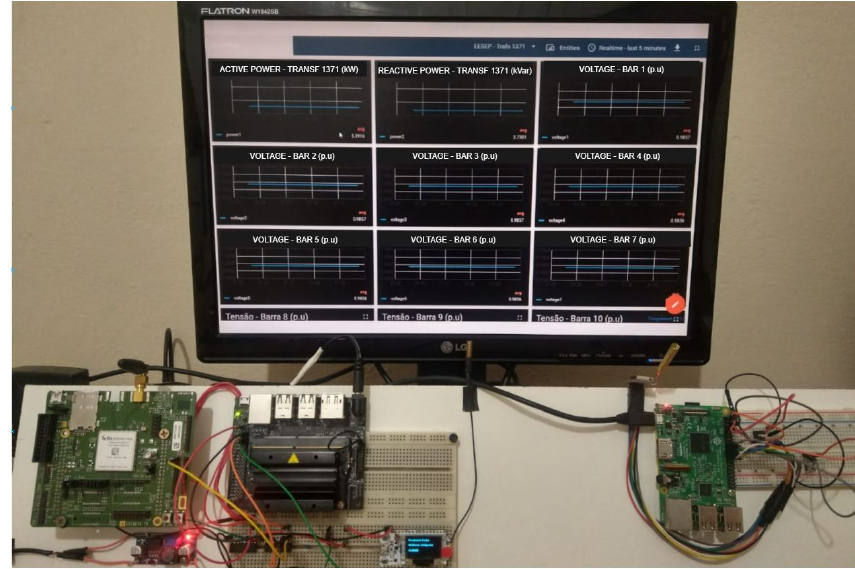
Figure 4. ThingsBoard Dashboard and electronic devices